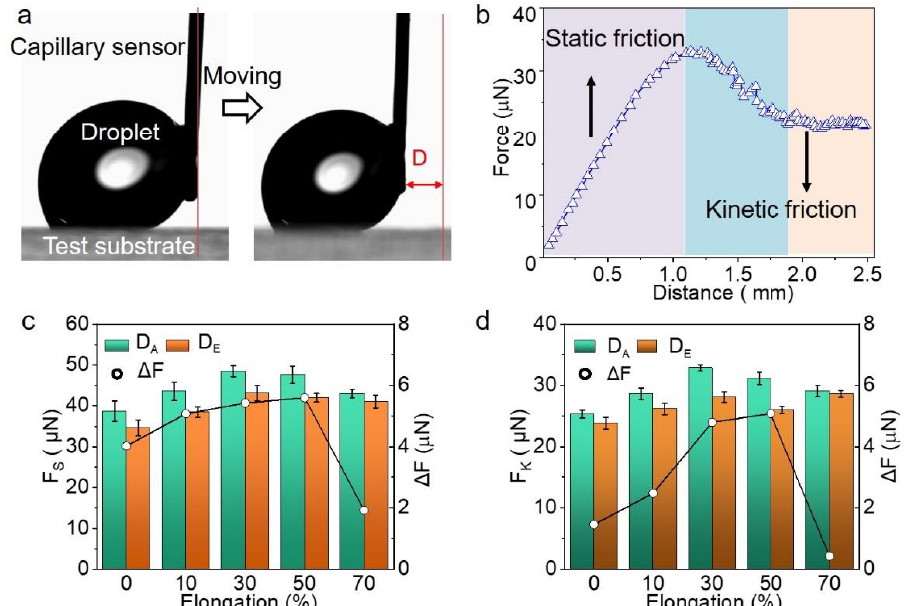
Figure 4. Friction force measurement of a water droplet on ATM. ( a ) Snapshots showing the measurement of friction force; ( b ) Typical curve showing the region of static friction and kinetic friction; ( c , d ) The dependence of ( c ) static friction force (F S ) along D A and D E and their difference (ΔF) and ( d ) kinetic friction force (F K ) along D A and D E and their difference (ΔF) on the elongation, respectively.